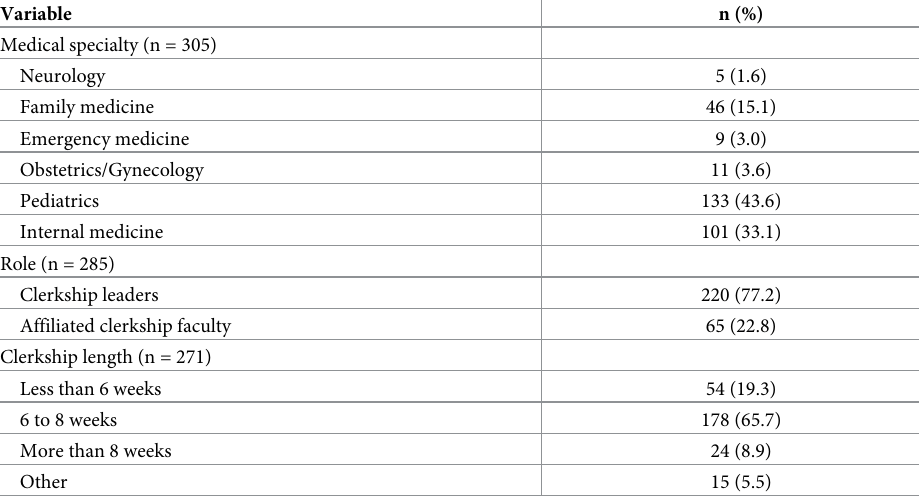
Table 2. Respondent